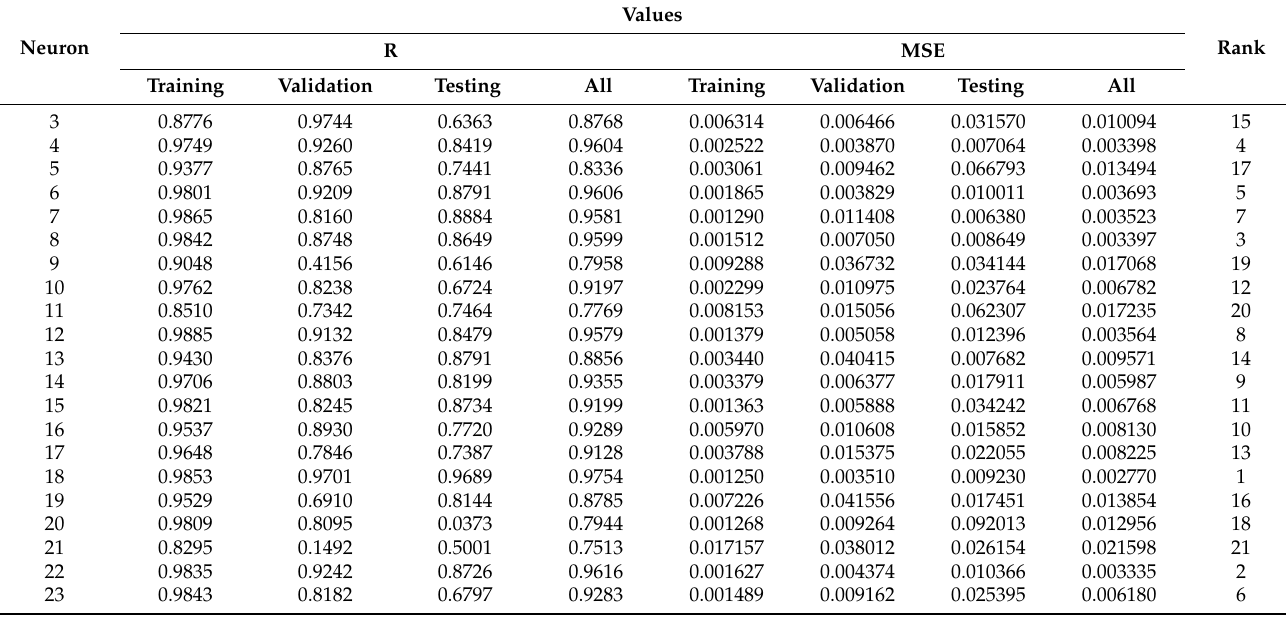
Table 4. Selection of best neuron based on performance criteria.